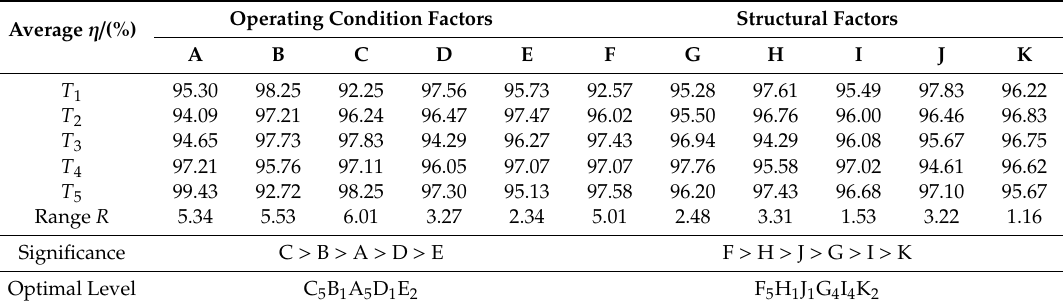
Table 2. Range analysis of each influential factor on separation e ffi ciency.